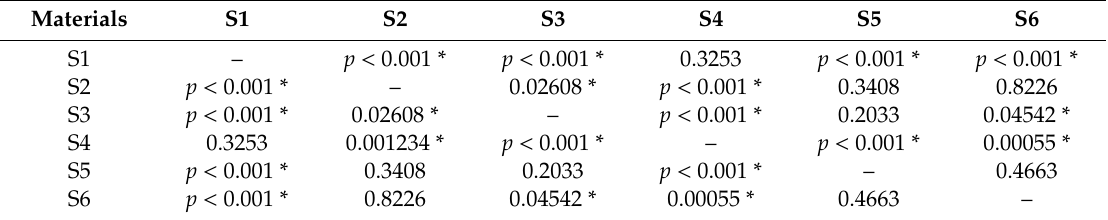
Table 1. Di ff erences in ∆ E after 168 h immersion in water.